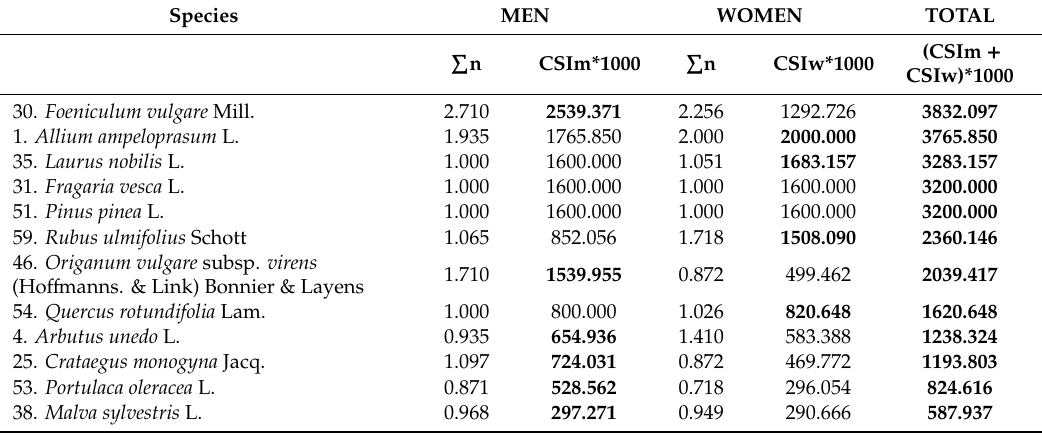
Table 3. List of the 79 taxa studied ordered from highest to lowest value for CSIm + CSIw. In addition, the values of “n” and “CSI” are included. When CSIw > CSIm or CSIm > CSIw, this appears in bold. + = cultivated